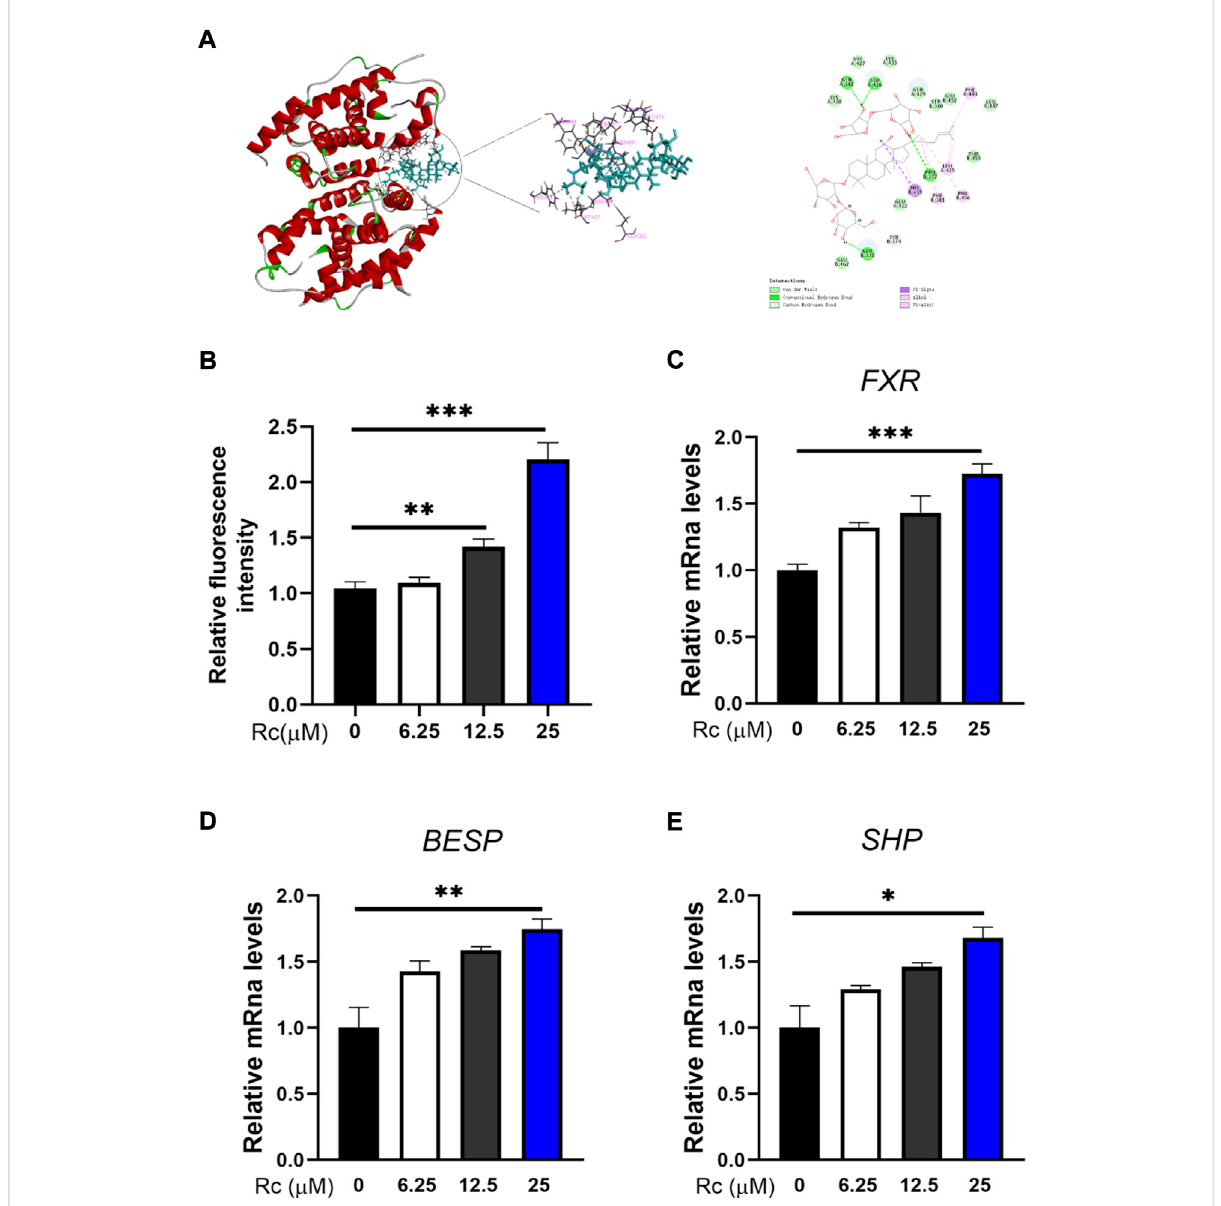
FIGURE 5 Rc activated FXR signaling pathway in LS174 cells: 3D and 2D molecular docking conformation of Rc with FXR (A) ; FXR reporter gene activity assay (B) ; the cells were collected for qPCR analysis, and the relative mRNA levels of FXR (C) , BSEP (D) , and SHP (E) were measured ( n = 4). Data are shown as the mean ± SEM. * p < 0.05, ** p < 0.01, *** p < 0.001 vs . the DMSO